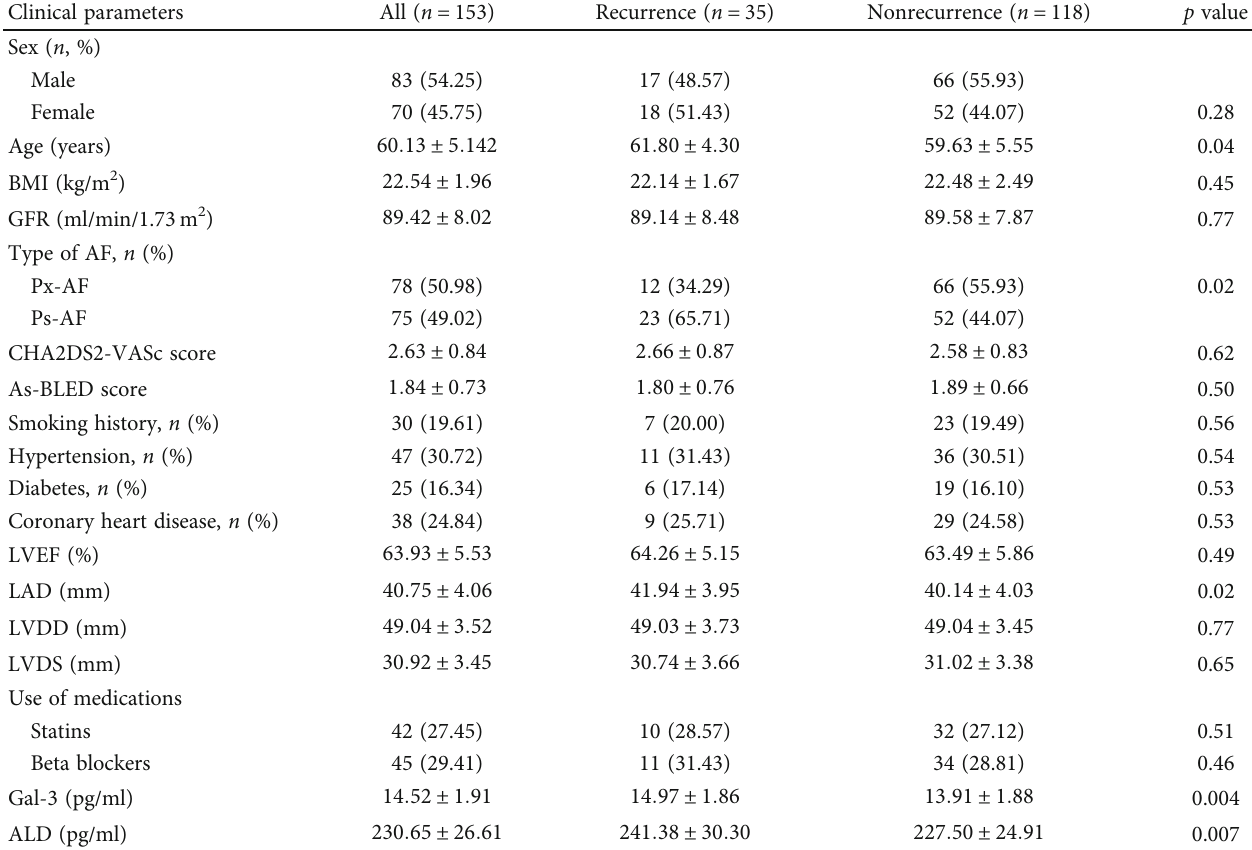
Table 1: Baseline characteristics of the study population.